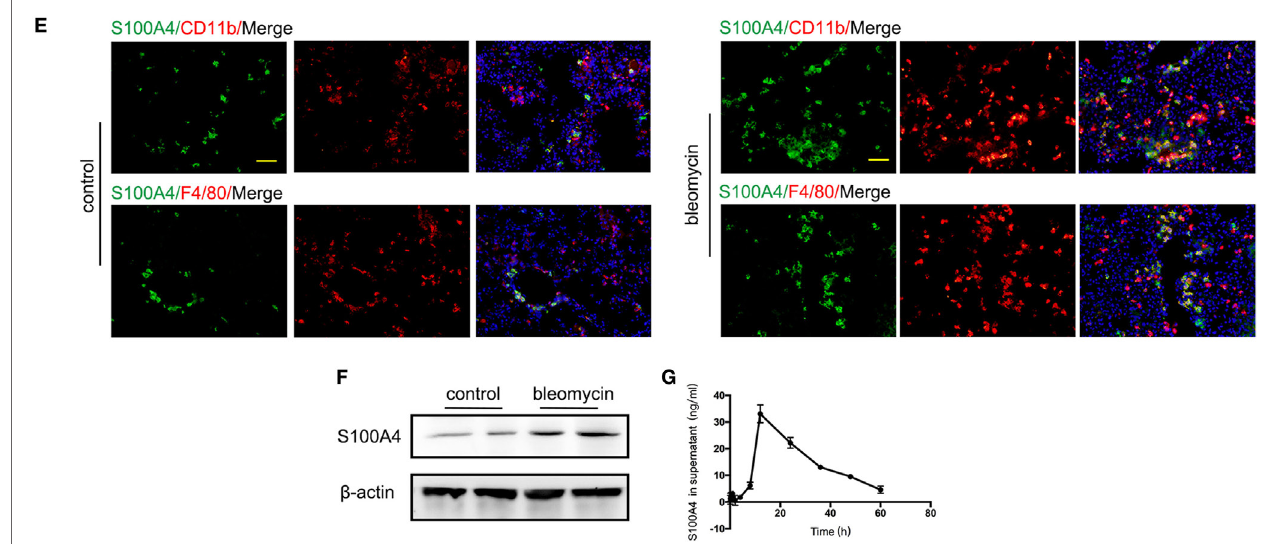
FigUre 2 | S100A4 + CD11b + F4/80 + cells are induced by bleomycin treatment in lung and correlate directly with pulmonary fibrosis. (a–D) S100A4 + / + GFP or (e,F) WT mice were treated once with bleomycin to induce pulmonary fibrosis. (a,B) Lung tissues of bleomycin-treated S100A4 + / + GFP mice were stained by H&E and Sirius Red at the indicated time points. Age-matched untreated mice served as control (day 0). Representative images from three independent experiments. Arrows point to borders between immune-cell areas and alveolar cells; dotted lines highlight areas with severe immune-cell infiltration, scale bar 100 µm. Mean ± SEM from n = 5 mice per time point and experiment, * p < 0.05 and ** p < 0.01, Kruskal–Wallis. (c,D) Whole lung-cell preparations stained for CD11b and F4/80 were analyzed in whole lung cells or in S100A4 + cells by flow cytometry. Representative dot plots from three independent experiments. Mean ± SEM from n = 4–5 per time point and experiment, * p < 0.05 and ** p < 0.01, Kruskal–Wallis. (e) Lung tissues from WT mice 14 days after bleomycin treatment were stained for S100A4 (green) in combination with CD11b (red; upper panel) or F4/80 (red; lower panel). Representative images for three independent experiments with n = 5 per experiment,